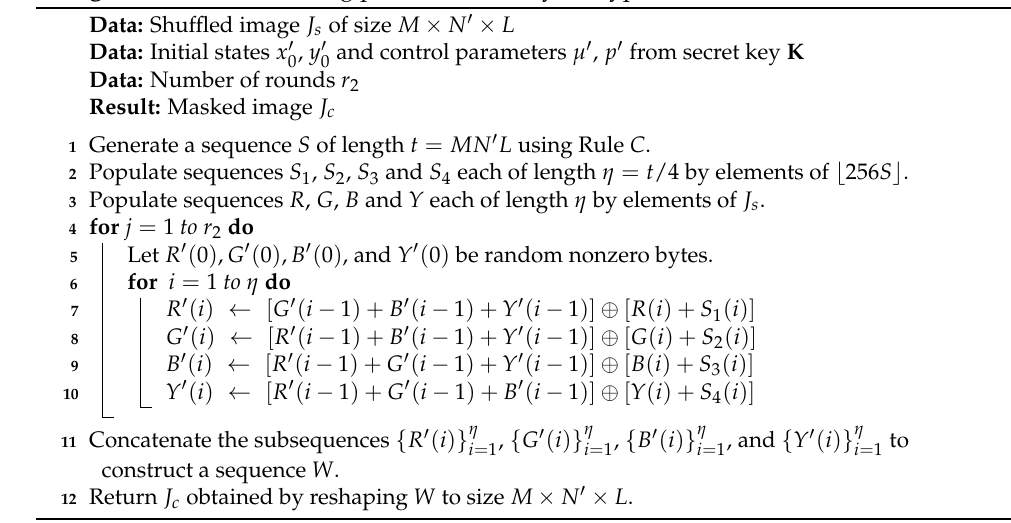
Algorithm 7: The masking phase of the lossy encryption scheme